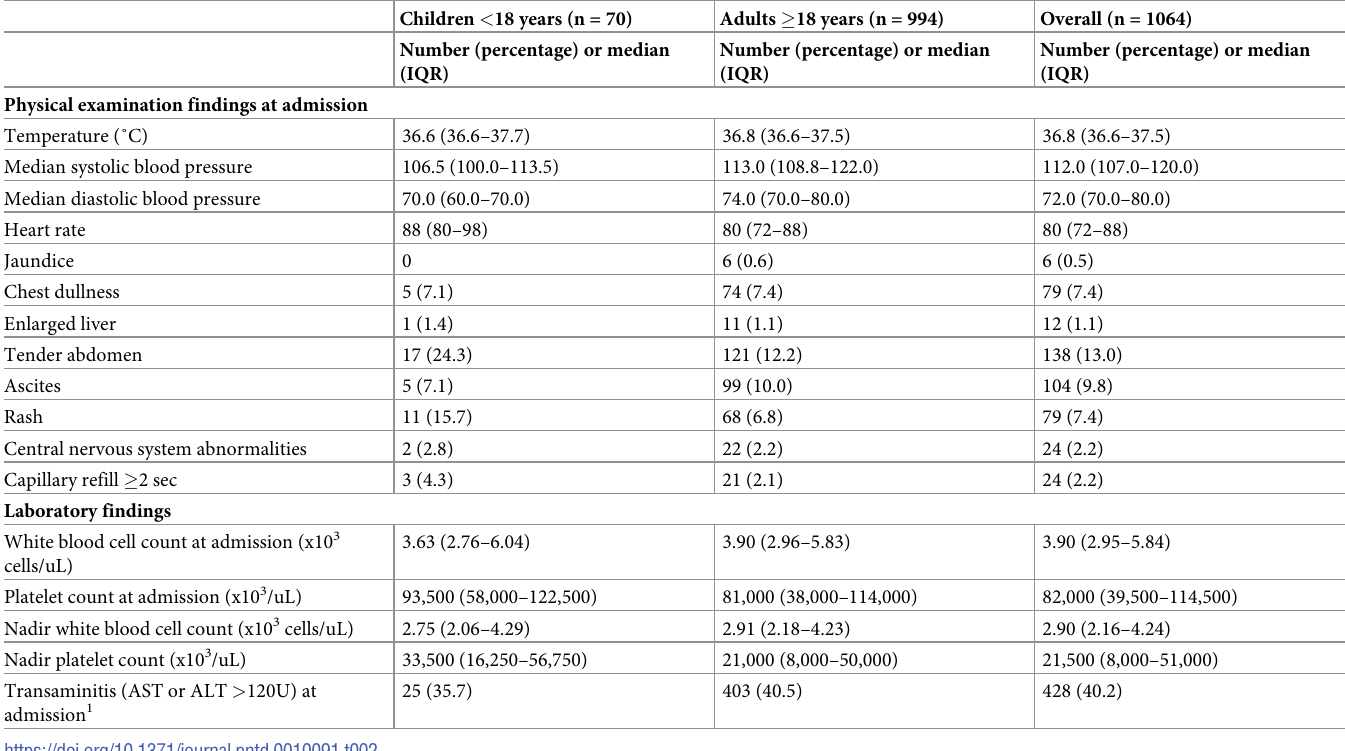
Table 2. Physical examination findings and laboratory results among children and adults with acute dengue in Southern Province, Sri Lanka,